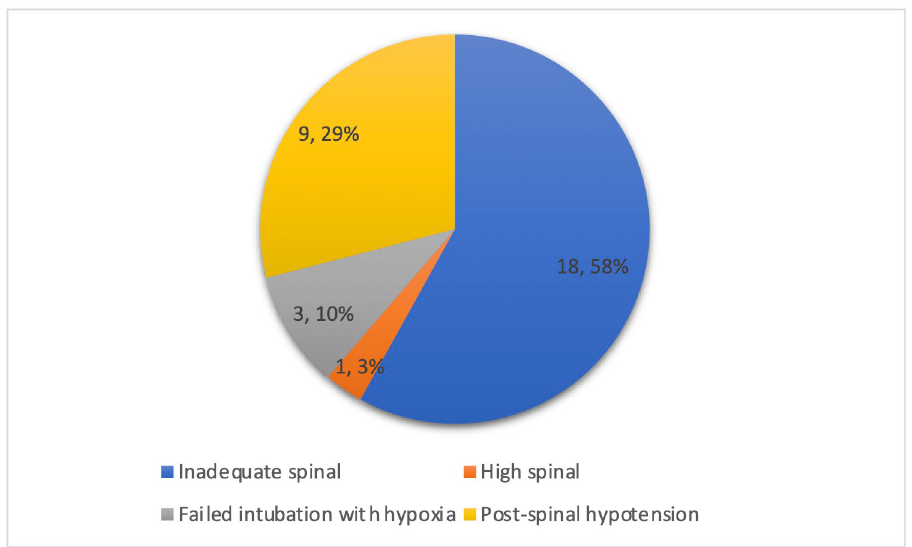
Fig 3. Frequency of anaesthetic complications